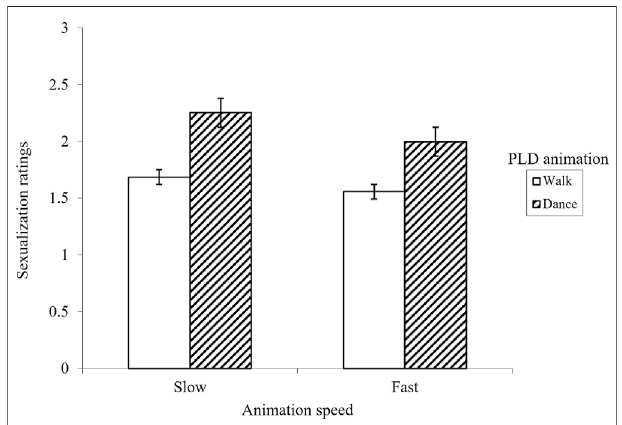
FIGURE 4 | Sexualization ratings (with 95% con fi dence interval) for animation speed by PLD movement animation.